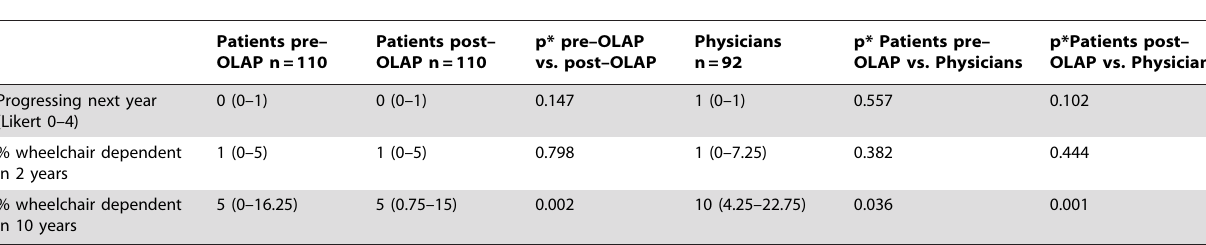
Table 3. Patients’ and physicians’ estimates of other progression